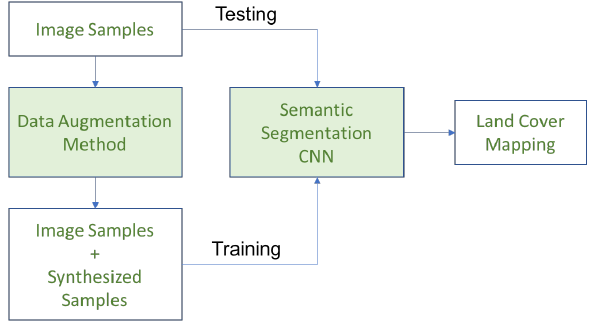
Figure 1. Semantic segmentation schema: with a given samples database, we propose a method to augment the training set, train the semantic segmentation CNN and evaluate its performance using the testing set